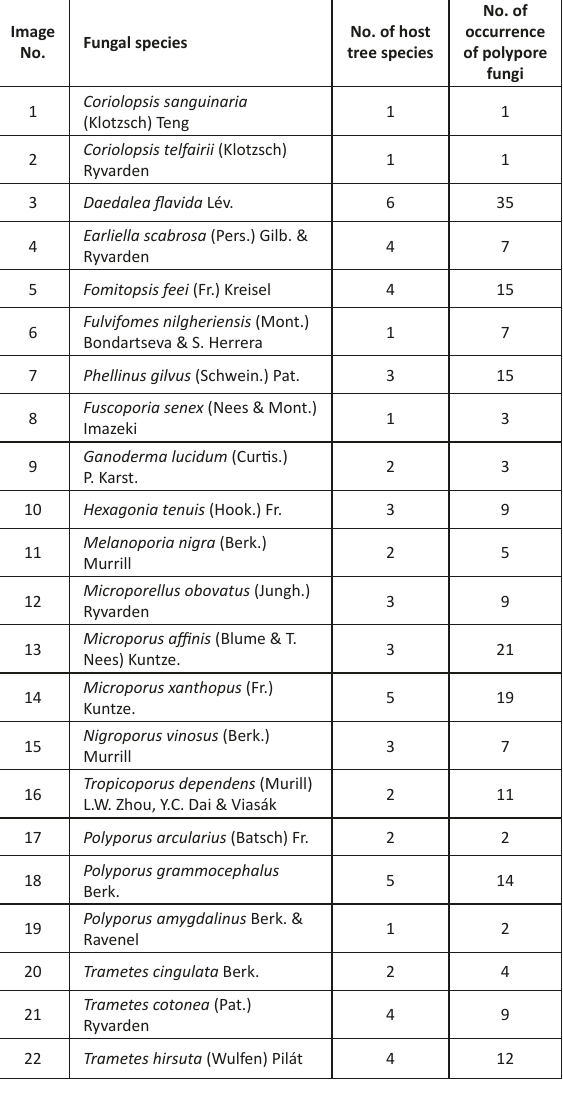
Host specificity of wood decaying fungi Iqbal et al. Table 2. Fungal species with number of occurrences and number of host tree